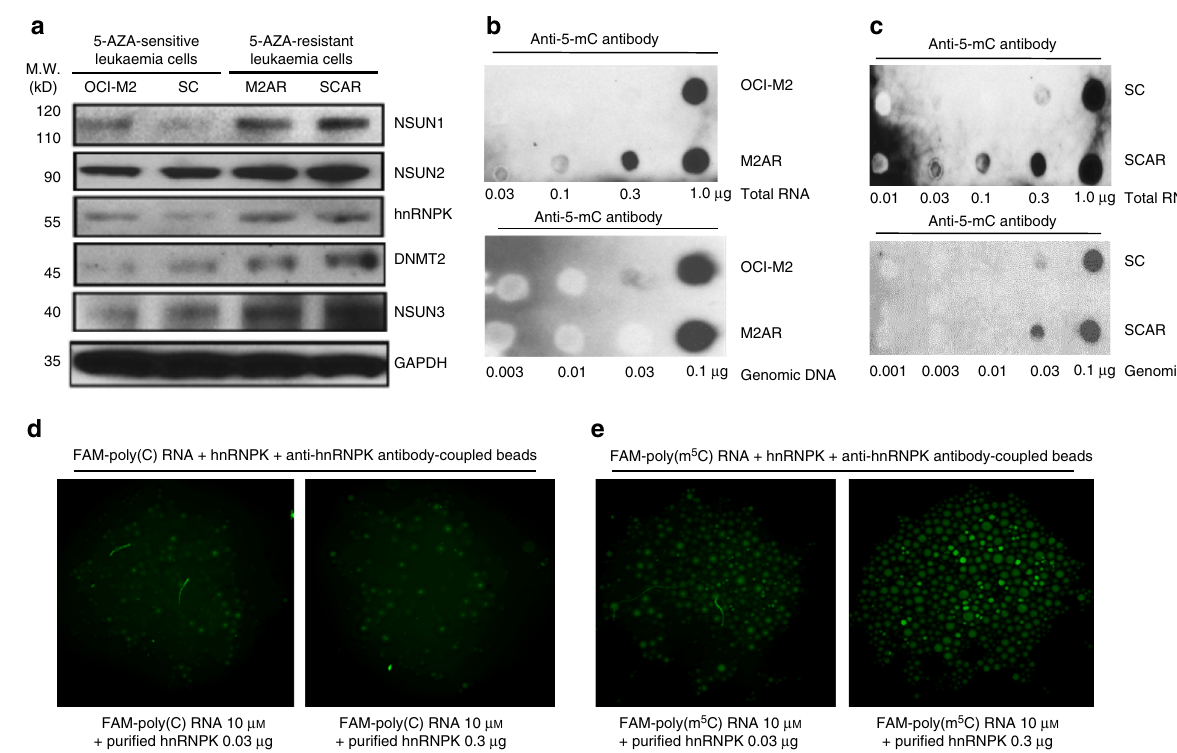
Fig. 1 Differential expression of RNA:m 5 C, RCMTs and hnRNPK in 5-AZA-sensitive and 5-AZA-resistant leukaemia cells and the binding of hnRNPK to unmethylated and cytosine-methylated RNA. a Western blot analysis of expression of RCMTs, hnRNPK and other proteins in the 5-AZA-sensitive OCI-M2 and SC leukaemia cells and the 5-AZA-resistant M2AR and SCAR leukaemia cells. b Dot blot analysis of 5-methylcytosine (m 5 C) in RNA and DNA from OCI-M2 and M2AR cells. c Dot blot analysis of 5-methylcytosine (m 5 C) in RNA and DNA from SC and SCAR cells. d , e Visualization and measurement of the binding of puri fi ed recombinant hnRNPK to the unmethylated and cytosine-methylated fl uorescein (FAM)-labelled RNA oligos by an antibody-coupled bead